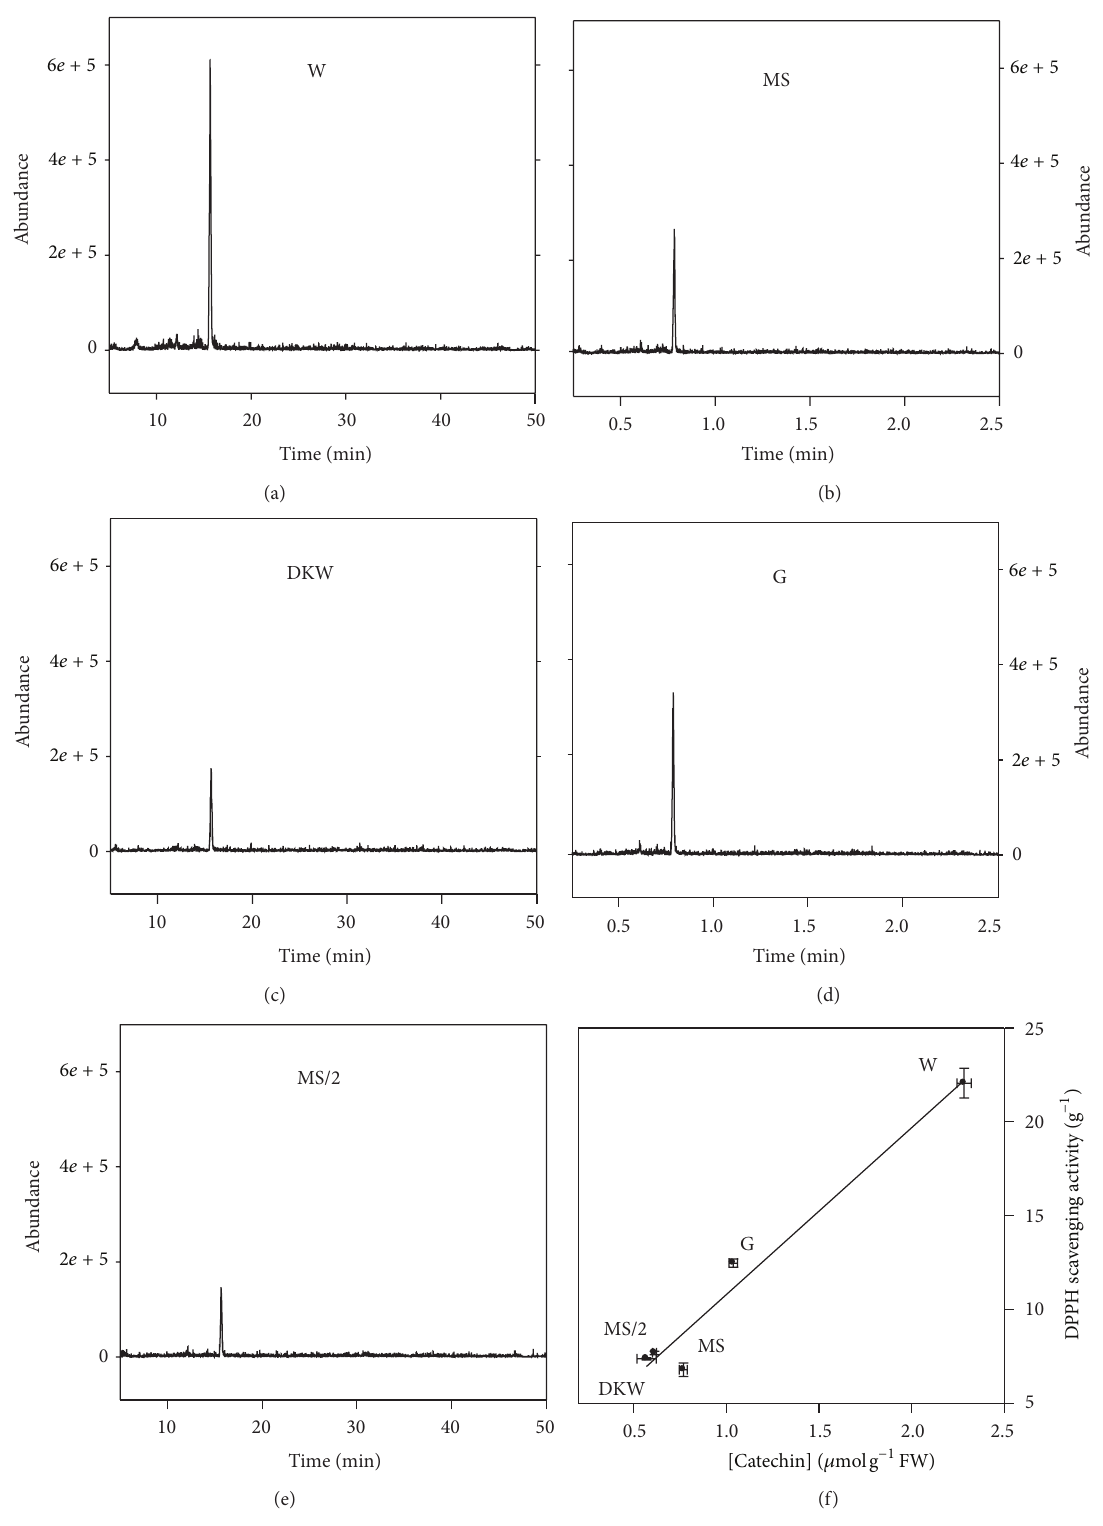
Figure 6: (a)–(e) Selected negative-ion HPLC-ESI-MS chromatograms of m/z = 289 corresponding to extracts of C. heterophyllus shoots cultured for 4 weeks in liquid medium containing the different basal media formulations used in this study. (f) Relationship between DPPH scavenging activity and catechin contents in shoots cultured for 4 weeks in liquid media containing the following basal media: G, Gamborg’s B5; DKW, DKW/Juglans; MS, full strength Murashige and Skoog; MS/2, half-strength macronutrients Murashige and Skoog; W,